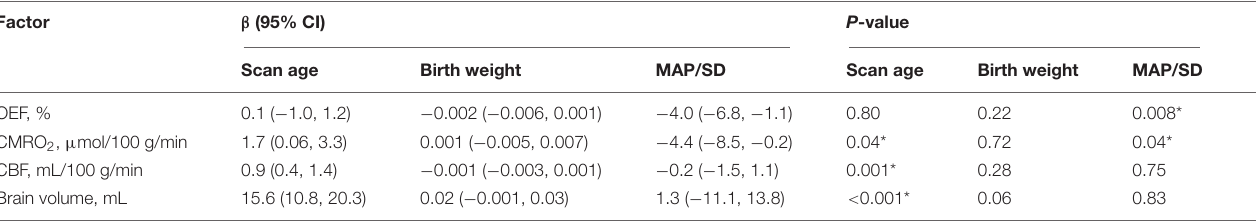
TABLE 5 | Association between maternal MAP (mmHg) and measured physiological parameters ( N = 38).